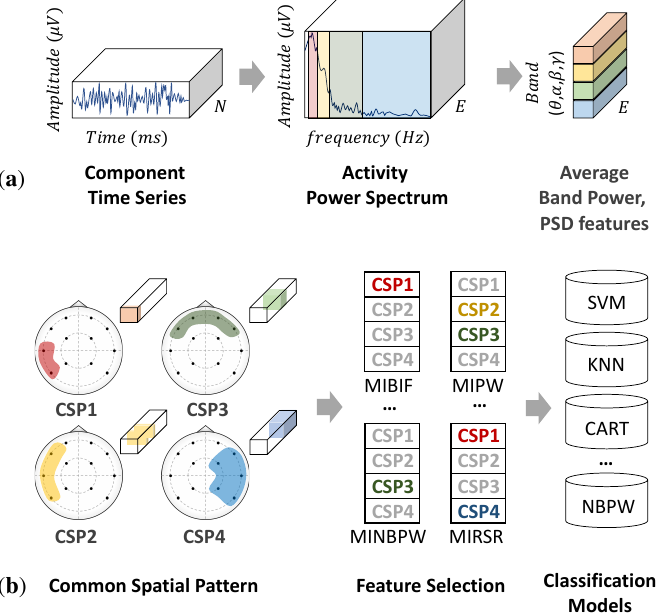
Figure 1. ( a ) Power spectral density (PSD) features, extracted from raw EEG signals. ( b ) Filter bank common spatial pattern